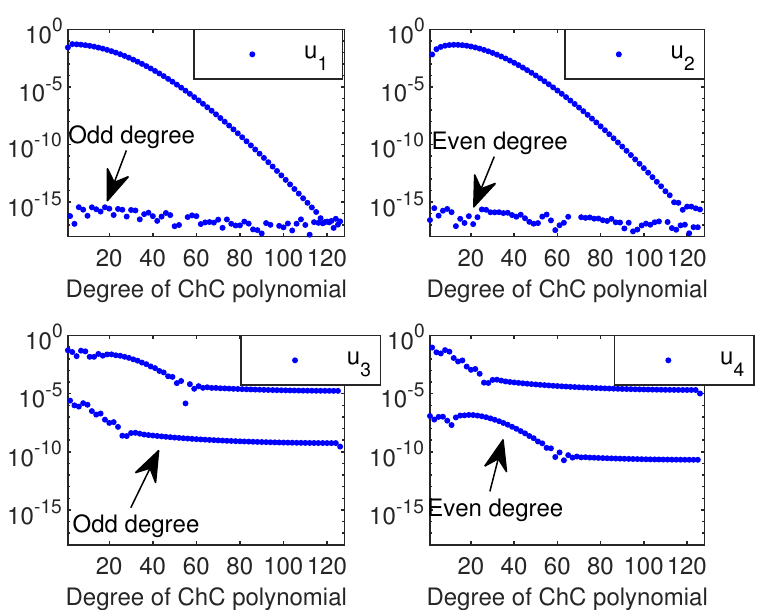
Figure 4. In a log-linear plot, the Chebyshev coefficients of the first four eigenvectors of the Coffey- Evans problem computed by ChC.